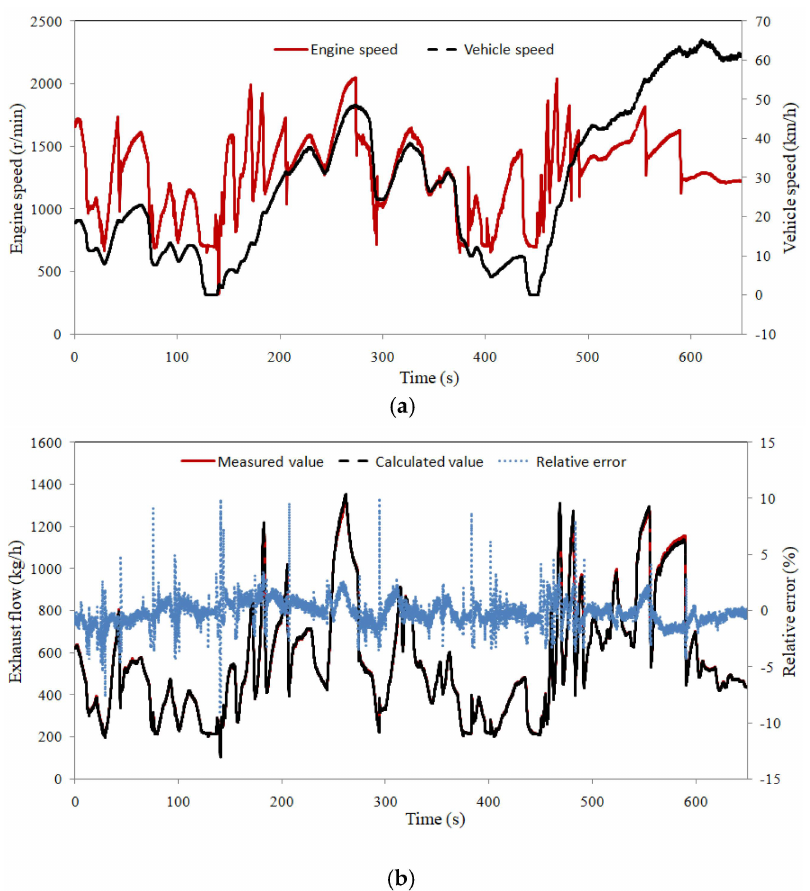
Figure 6. Comparison curve of vehicle actual road exhaust flow under transient-state conditions. ( a ) Engine speed and vehicle speed; ( b ) measured and calculated value of exhaust flow